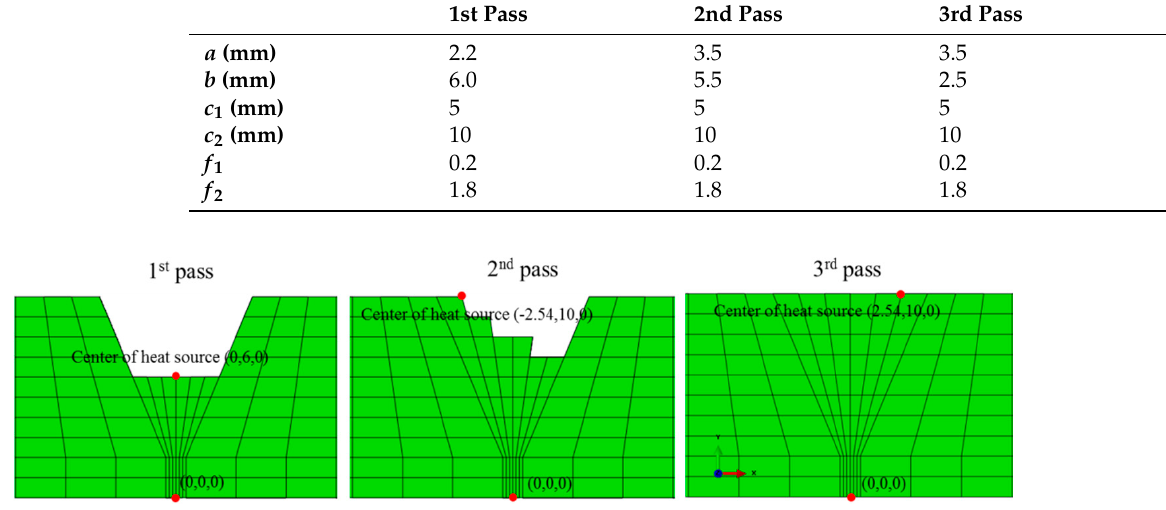
Figure 8. Heat source center modification for each pass (mm unit).